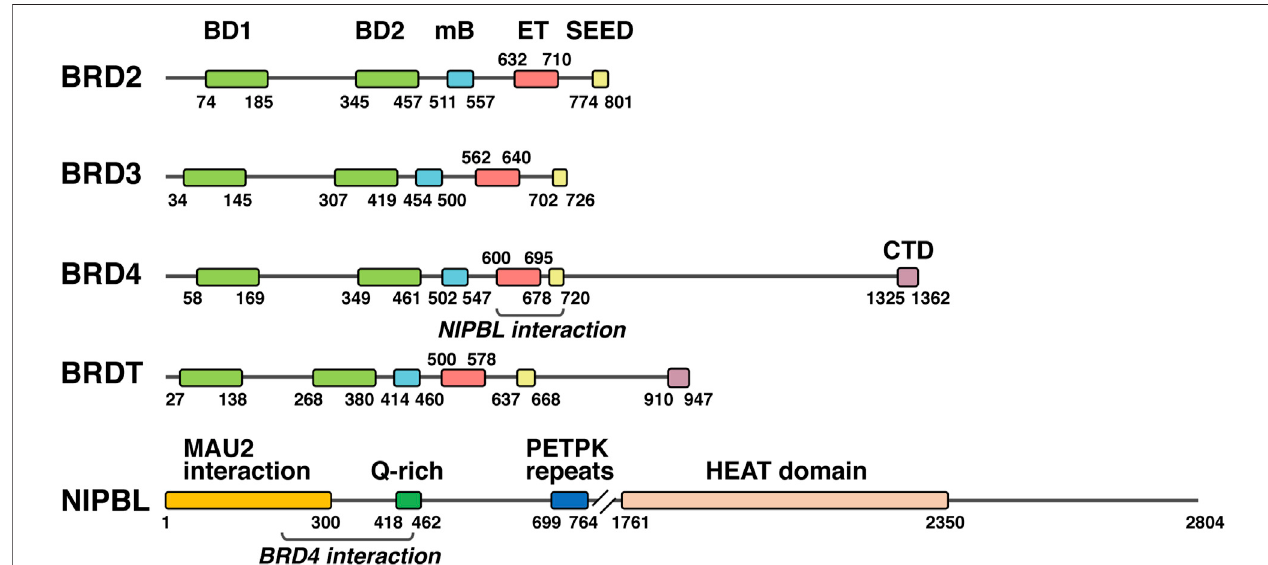
FIGURE 2 | NIPBL and BET proteins. Schematic representation of the different human BET proteins together with NIPBL, indicating the amino acid position (numbers)ofmaindomainsandtheregionsinBRD4andNIPBLinvolvedintheinteractionbetweenthem.BD1,bromodomain1;BD2,bromodomain2;mB,motifB;ET, extra terminal domain; SEED, SEED domain; CTD, C-terminal